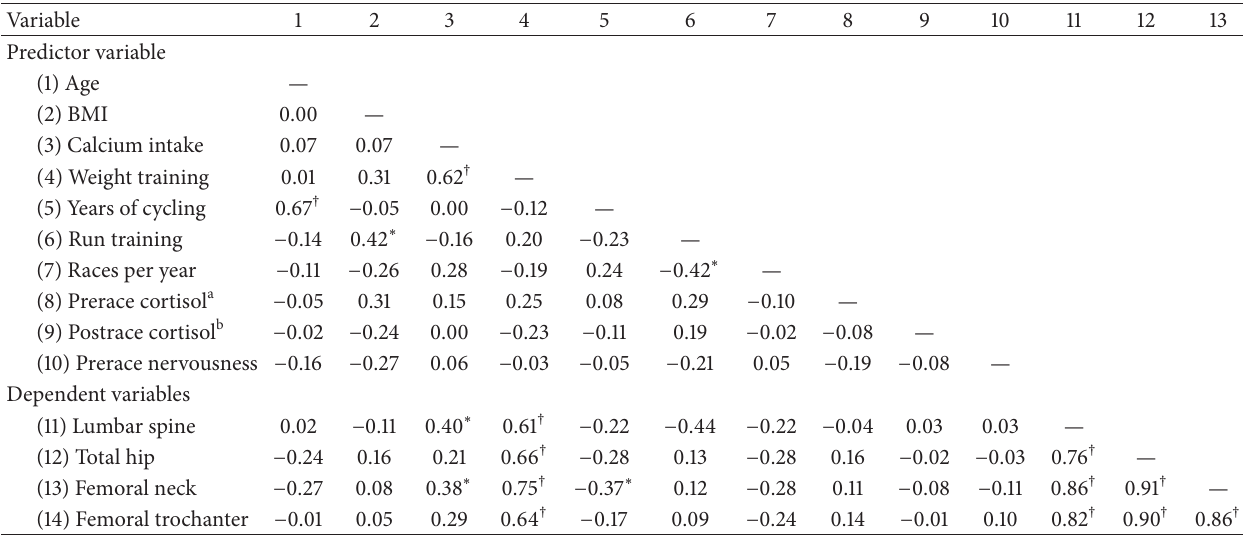
Table 3: Correlations for BMD and cyclist characteristics ( 𝑁 = 30 ).